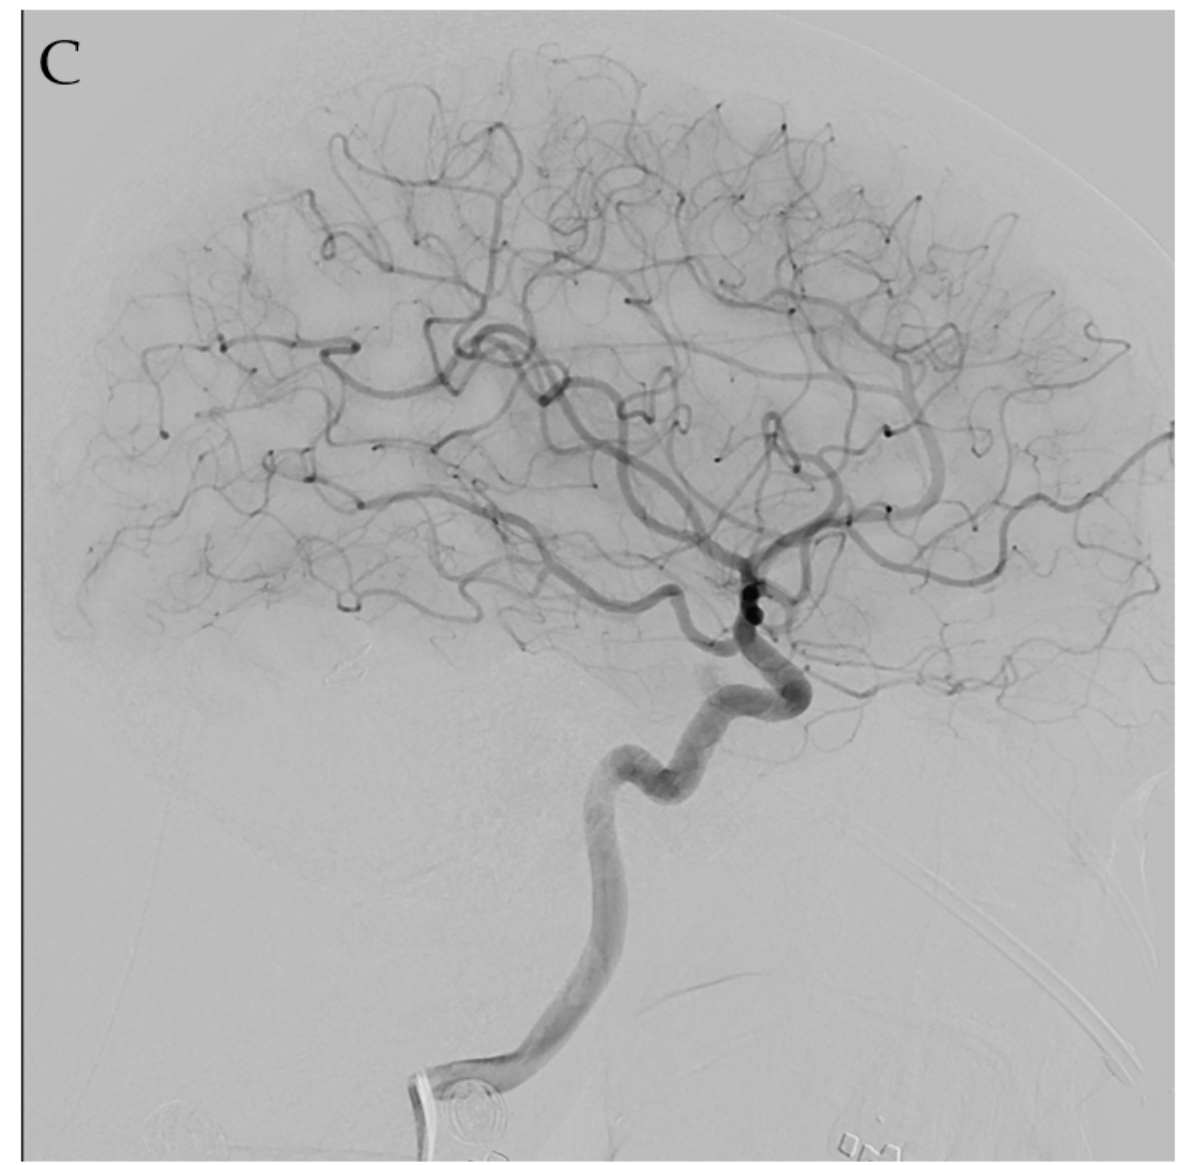
Figure 2. A 47-year-old female who presented with headaches and dizziness found to have an unruptured left anterior frontal lobe SM grade I AVM on MRI ( A ) with arterial supply from an orbitofrontal branch of the anterior cerebral artery (ACA) with venous drainage via a cortical vein into the anterior superior sagittal sinus ( B ). The patient was presented with microsurgical resection, embolization, and SRS as treatment options. Given the risk of residual AVM after embolization and a latent period between SRS and AVM obliteration, the patient opted for microsurgical resection. Follow-up angiography demonstrated no residual lesion ( C ).